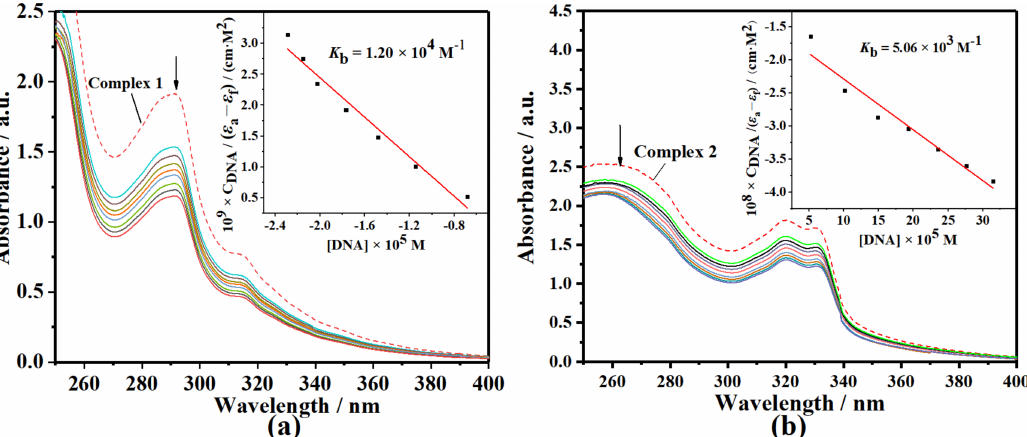
Figure 2. The electronic absorption spectra of complex 1 ( a ) and complex 2 ( b ) with or without CT-DNA. Arrows indicate changes in absorbance with escalating DNA quantity. Inset: [DNA]/( ε a − ε f ) vs. DNA] plots.